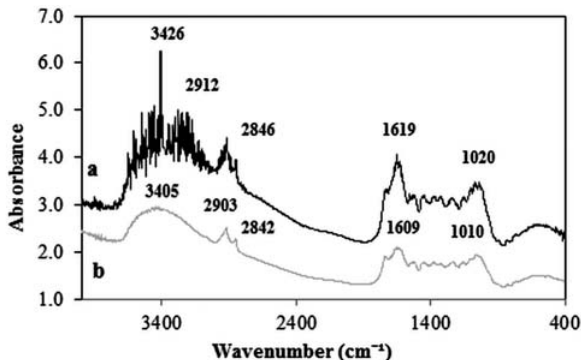
Figure 7. FTIR spectra of untreated WGT before adsorption (a) and after MG adsorption (b).